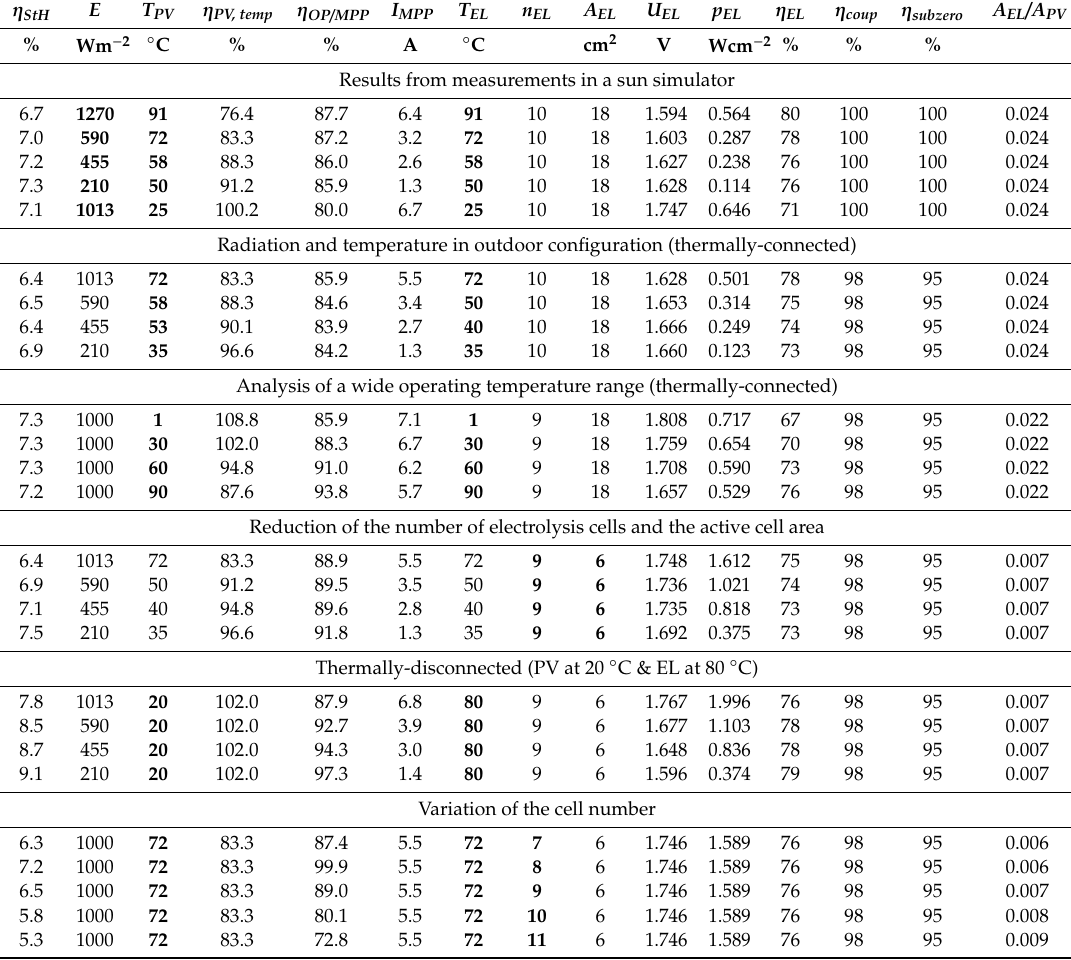
Table 4. Parameter variation for a PV panel with η PV,25 ◦ C,MPP =